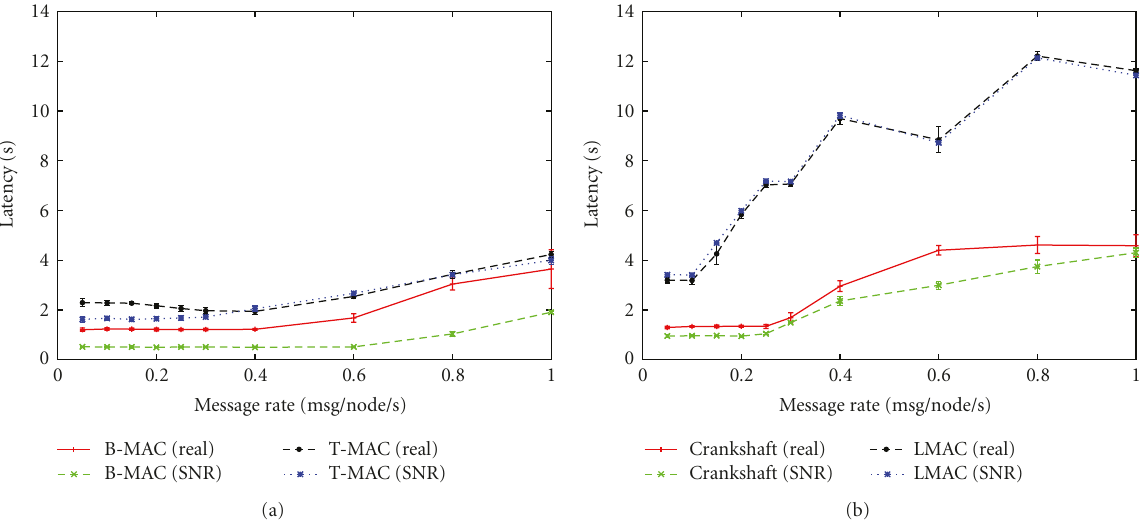
Figure 6: Average packet latency for simulated and real convergecast experiments.